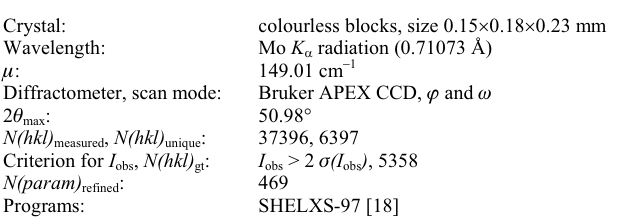
Table 1. Data collection and